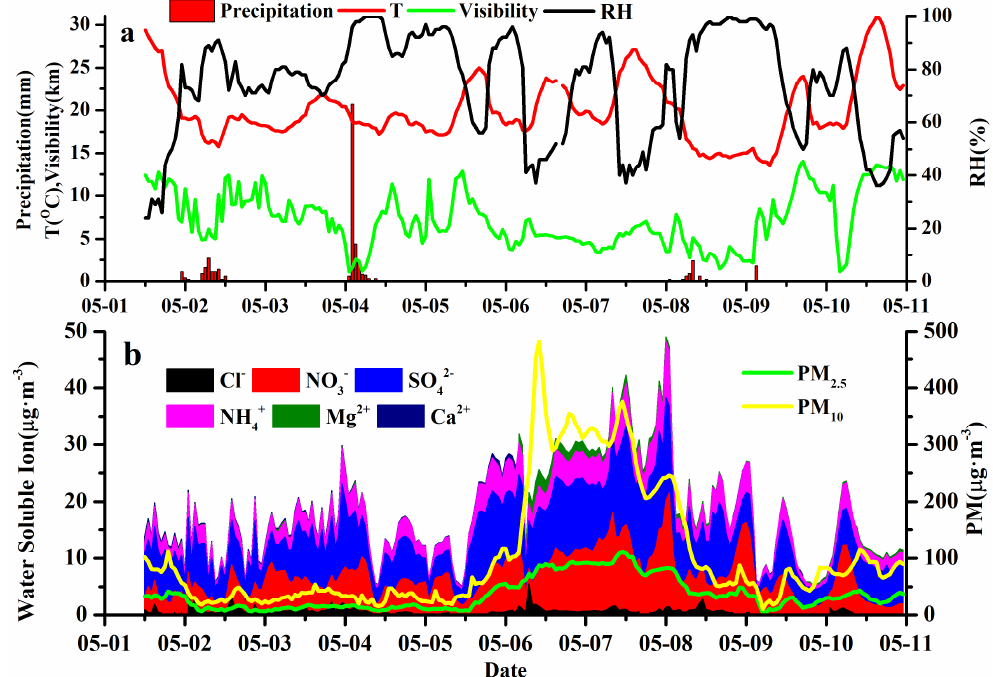
Figure 2. Time series of air pollutants and meteorological elements during the observation period.